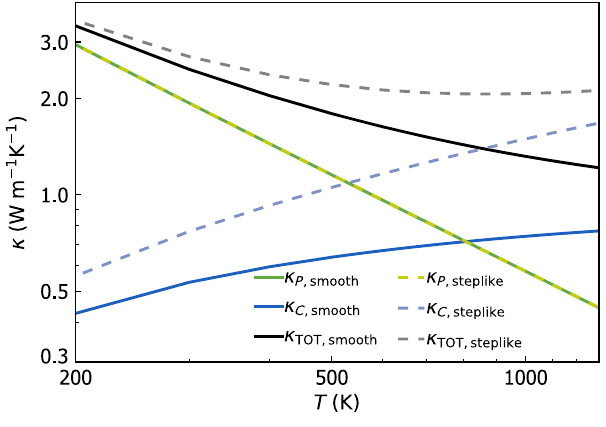
FIG. 12. Effect of the phase convention on the thermal conductivity of La 2 Zr 2 O 7 . Solid lines are the conductivities computed using the correct size-consistent smooth phase con- vention, dashed lines are the conductivities computed using the size-inconsistent steplike phase convention. The populations ’ conductivities are green ( κ P ), and they are equal in the two phase conventions (see text). The coherences ’ conductivities ( κ C ) are blue. The total conductivity (black) is given by the sum κ κ κ P þ C . Using the steplike phase convention yields a tot ¼ total conductivity larger than that obtained using the smooth phase convention. We recall that the populations and coherences conductivity tensors of La 2 Zr 2 O 7 are proportional to the identity (see Sec VII A); thus populations and coherences conductivities are represented here as scalars.